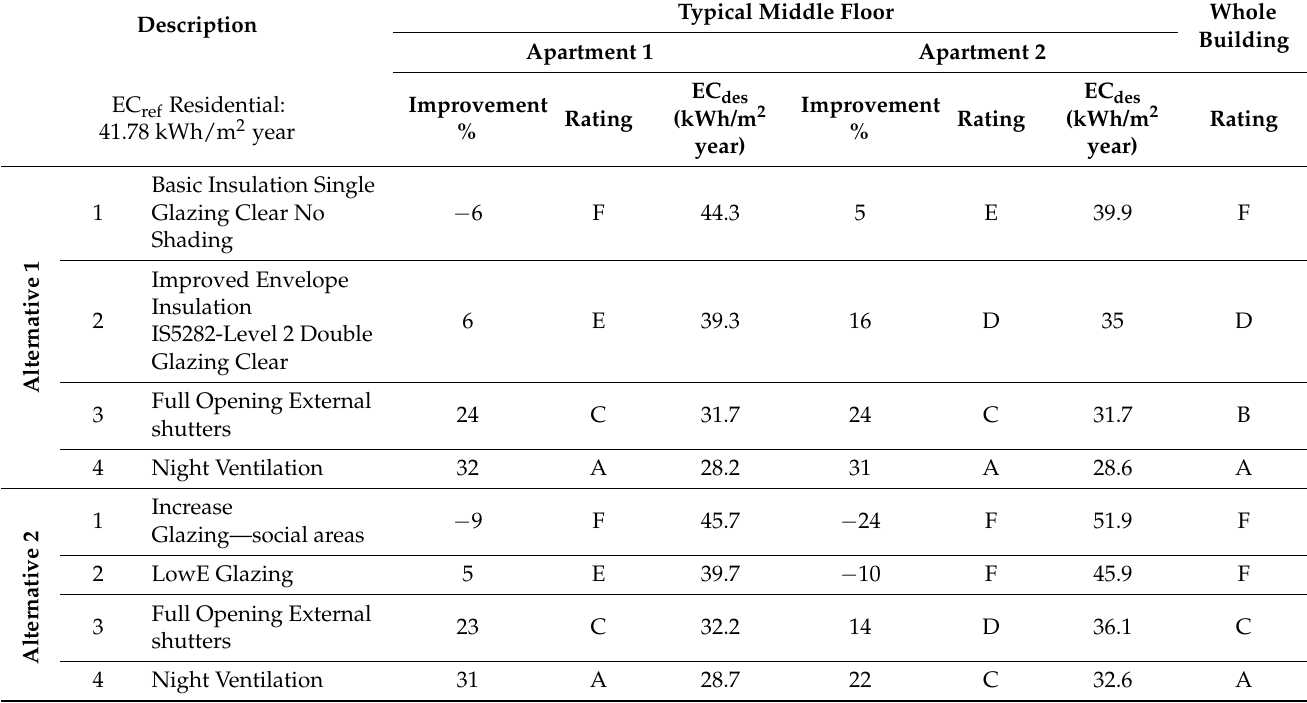
Table 5. Design path showing improvements of two design